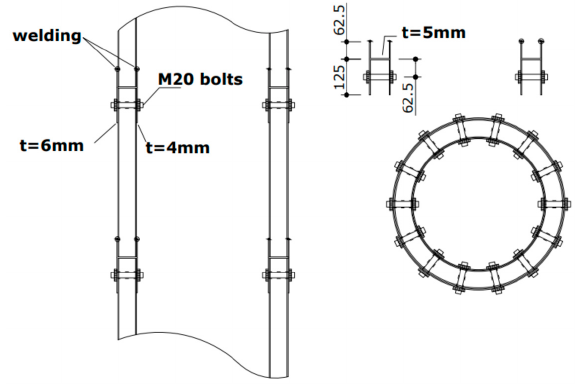
Figure 9. H-connector (Type-H).